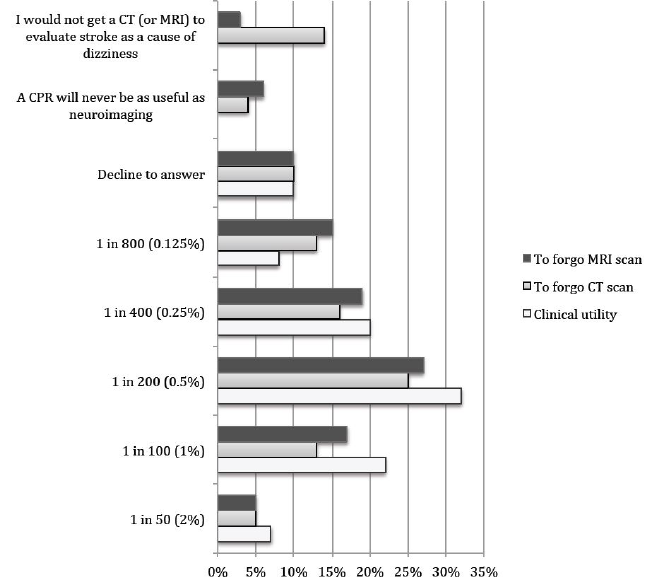
Figure 4. Ideal posttest probability for a CPR to be useful in evaluating patients with dizziness. a,b a 9 missing responses b Survey question 8: first two choices were not an option for the question about clinical